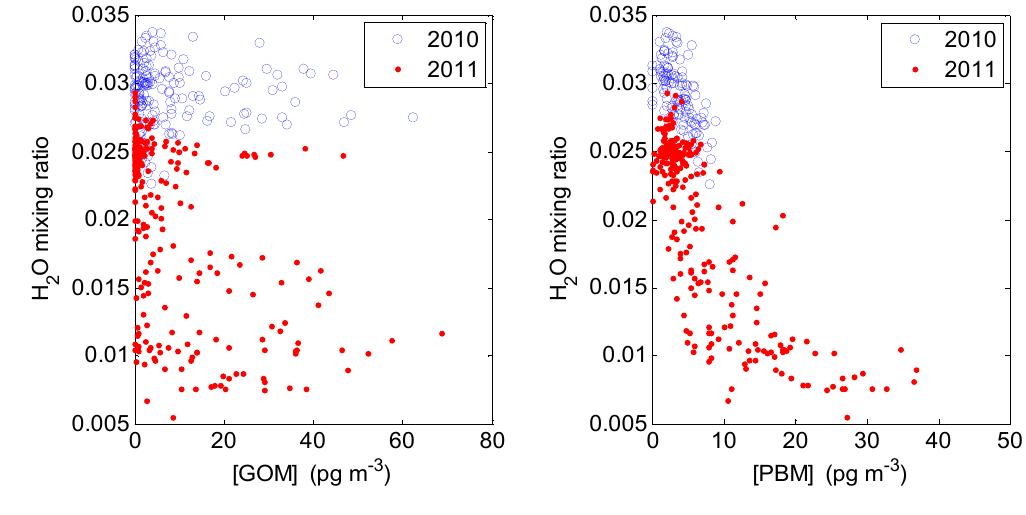
Figure 9. ( Left ) hourly averaged water volume mixing ratio versus GOM concentration during the 2010 intensive (blue circles) and the 2011 intensive (red dots). ( Right ) hourly averaged water volume mixing ratio versus PBM concentration during the 2010 intensive (blue circles) and the 2011 intensive (red dots). Data collected during the day with solar radiation greater than 10 W·m − 2 are